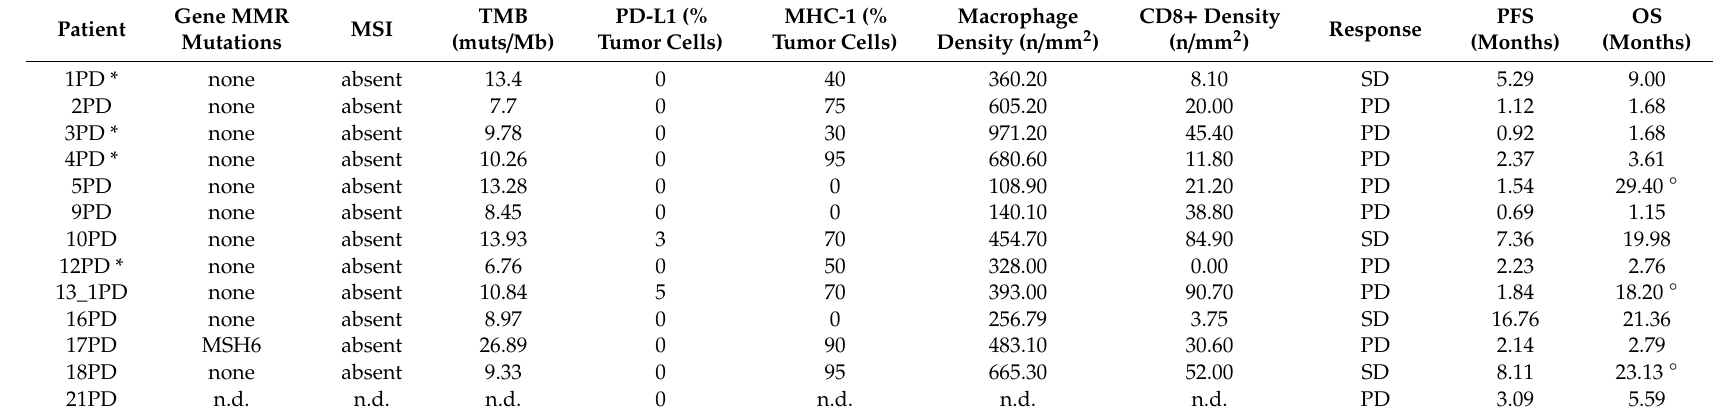
Table 2. Molecular data and outcome of the 13 patients enrolled in the